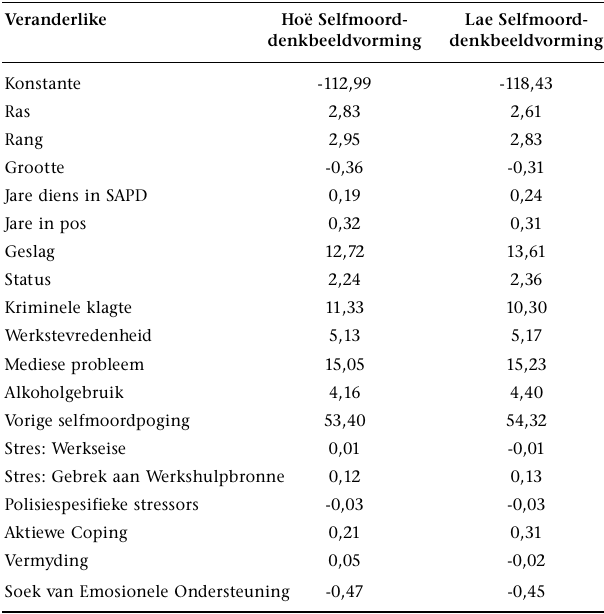
In Tabel 6 word die lineêre diskriminantfunksie vir polisielede met lae en hoë selfmoord-denkbeeldvorming uiteengesit. T ABEL 6